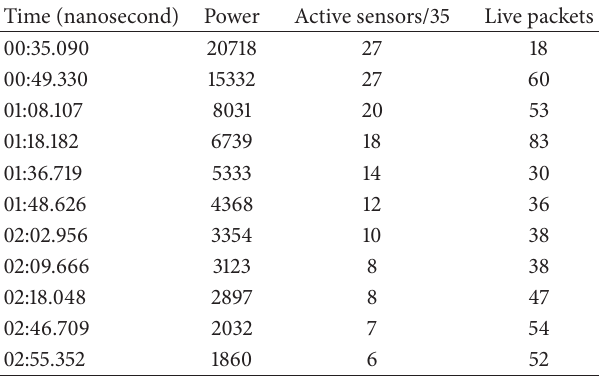
Table 3: Observed values in the early times of network.